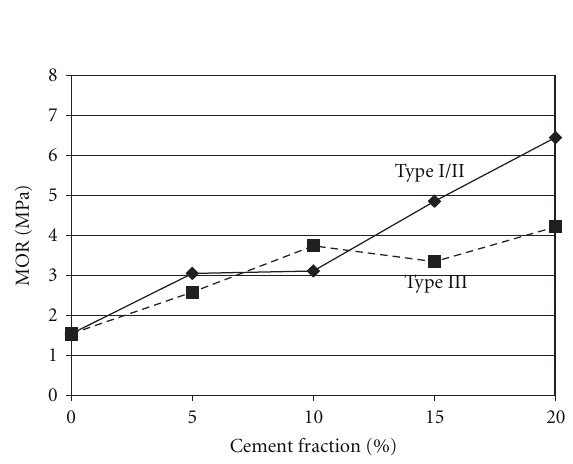
Figure 7: Comparison of MOR at 28 days for mixtures with type I/II and type III cement.